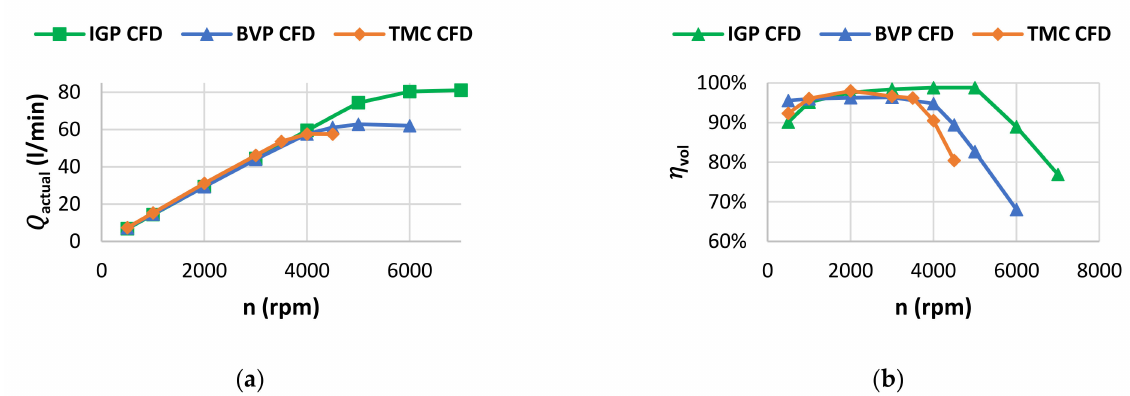
Figure 14. Comparison of the CFD data for the conveying characteristics ( a ) and the volumetric efficiencies ( b ) at 22.5 bar pressure load and 20 ◦ C oil temperature.